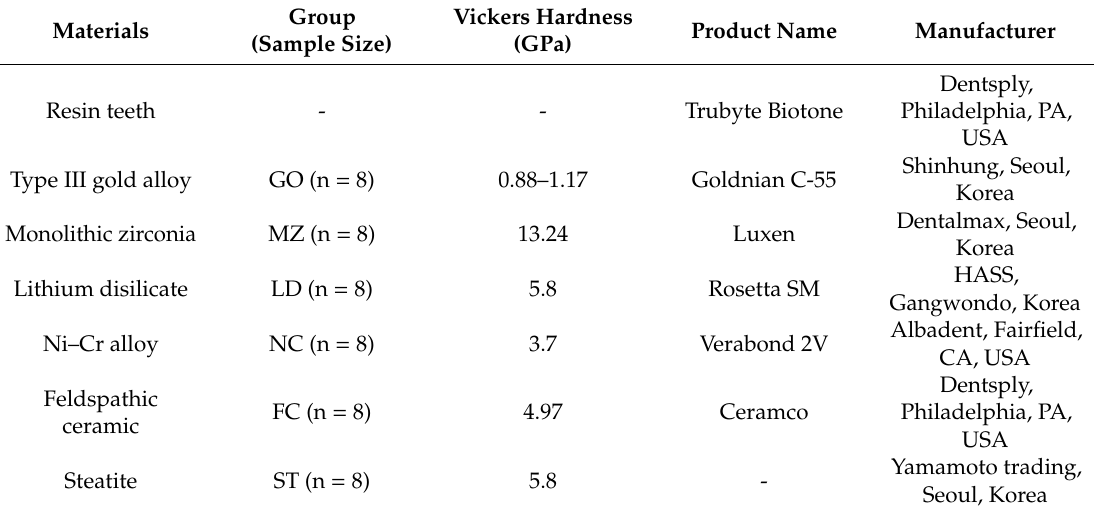
Table 1. Materials examined in this